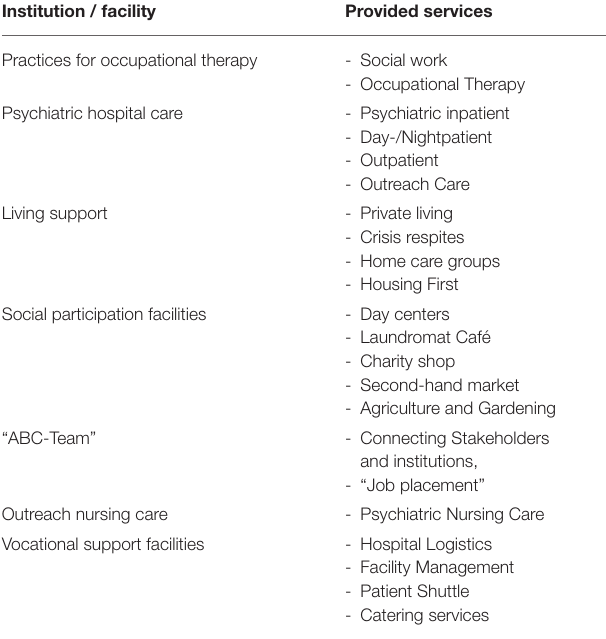
TABLE 1 | Overview of the main institutions (and provided services) that cooperate with the Geesthacht